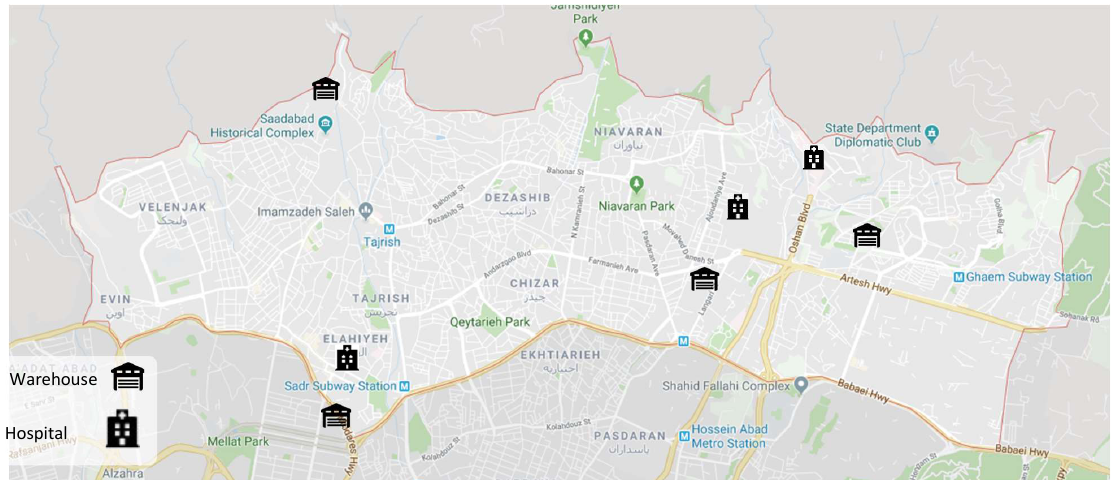
Fig. 2. The location of these warehouses and medical centers in Tehran region